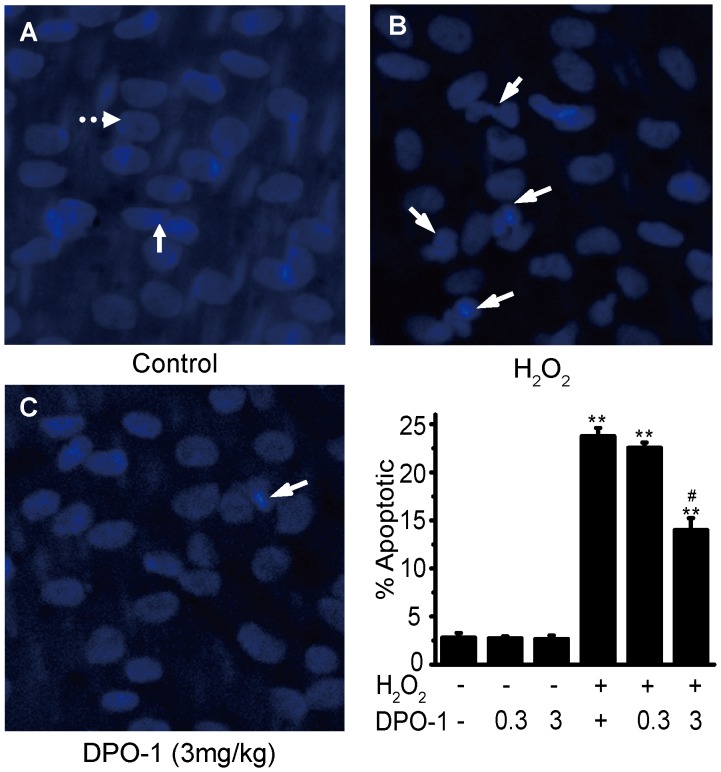
Kv1.5 inhibitor, DPO-1 attenuated H2O2-induced in vivo EC apoptosis in rat carotid artery.DPO-1(0.3, 3 mg/kg) was i.p. dose administrated at 6 hours after H2O2 injury. Representative morphological changes of apoptotic ECs were determined by en face Hoechst 33342 staining in Control (A), H2O2 injury (B) and DPO-1 treatment (C) groups. The contralateral side of carotid artery at 6 h after injury served as control, nuclear morphology of normal ECs (round, shown by full line arrow in (A)) and VSMCs (spindle-shaped, shown by dotted line arrow in (A)) can be observed. In (B) & (C), the white arrows show typical apoptotic morphological changes in apoptotic ECs, including chromatin condensation and nuclear fragmentation. The values were presented as ± SEM of 6 independent experiments. * P<0.01 vs. control, # P<0.01 vs. H2O2 group.